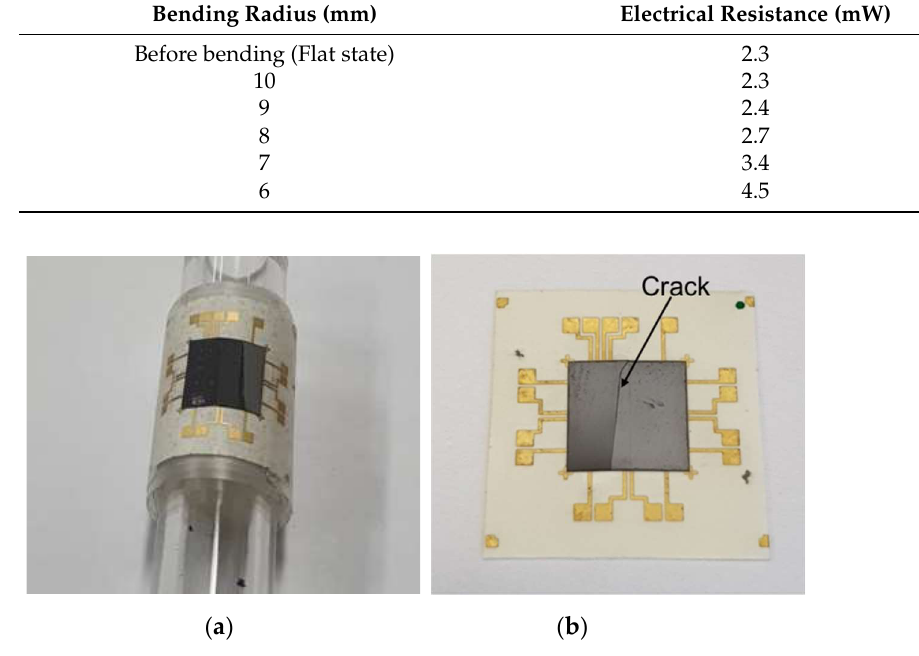
Figure 16. ( a ) Image of the bending test of the flexible device at a bending radius of 6 mm. ( b ) Optical image of crack in the silicon chip after bending test.